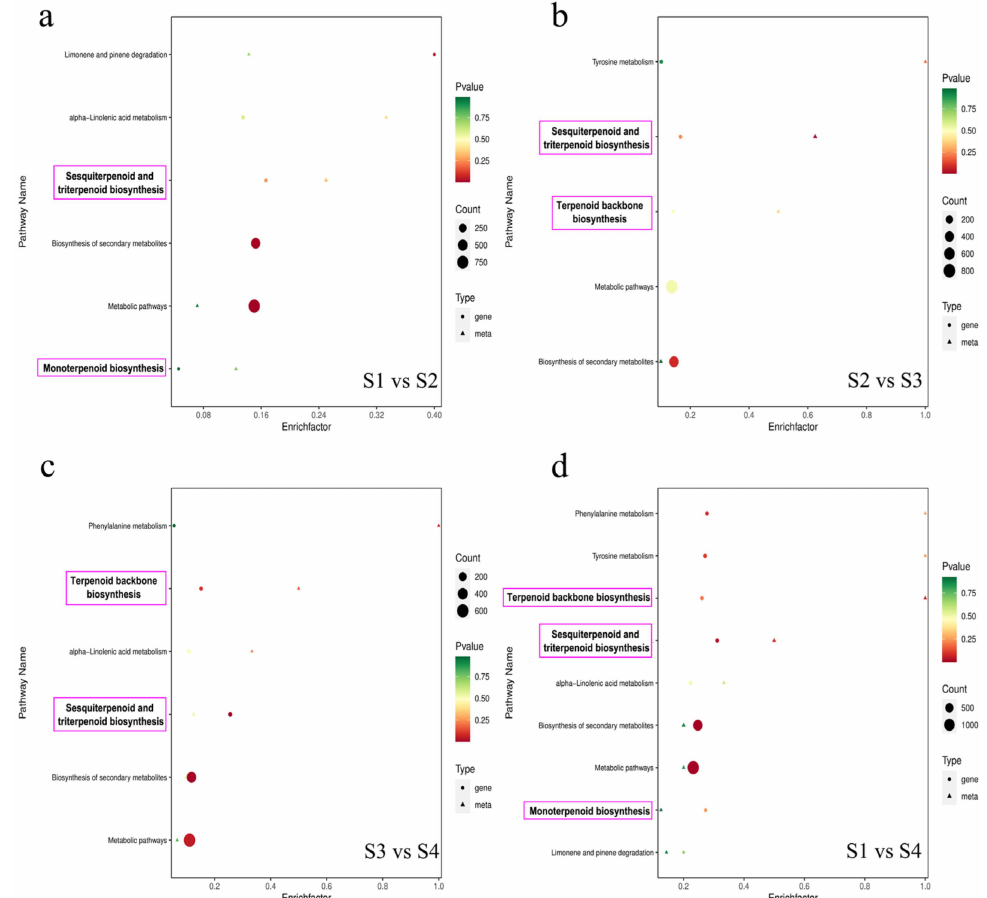
Figure 3. Bubble map drawn for the KEGG pathway enriched with metabolomics and transcriptomics. ( a – d ) The abscissa represents the pathway enrichment factor (Diff/Background) in different omics, and the abscissa is the name of the KEGG pathway. The gradient of red–yellow–green shows the variation in the significance of high–medium–low enrichment represented by the p -value. The bubble shape stands for omics, the bubble size shows the number of differential metabolites or genes, and a larger number means a larger